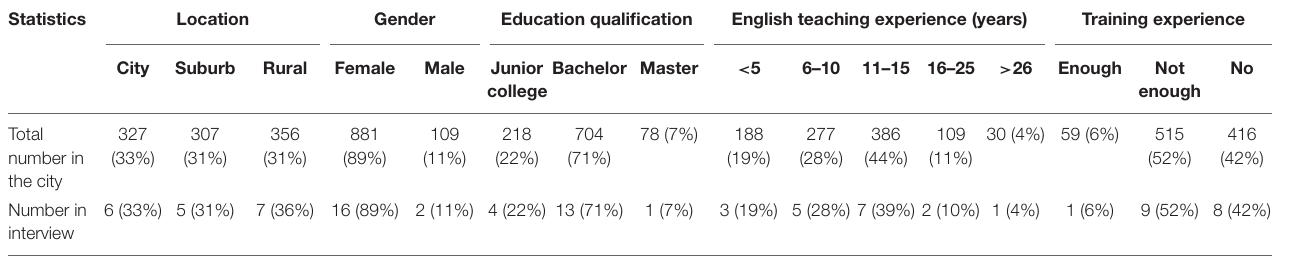
TABLE 5 | The characteristics of the interview respondents ( n =